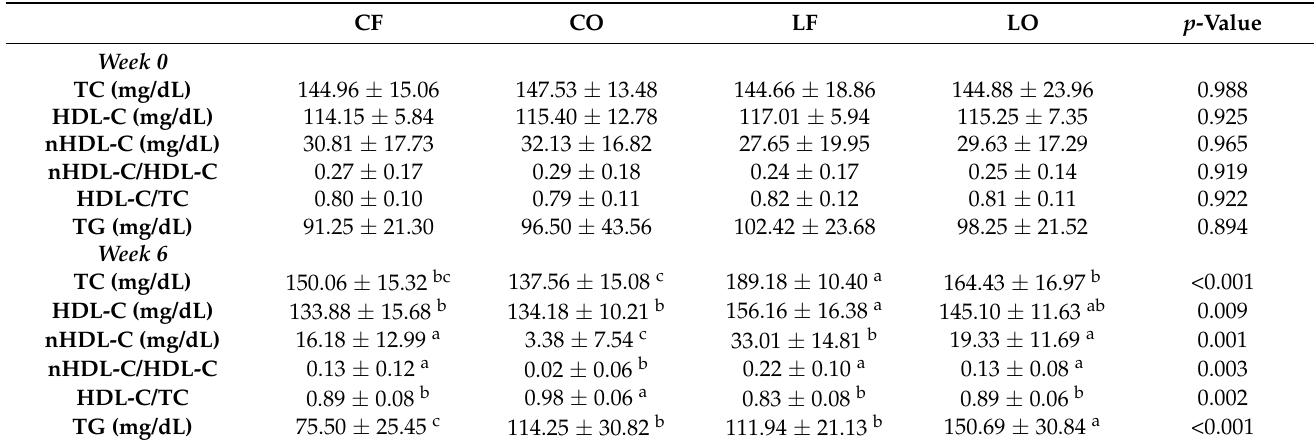
Table 4. Plasma lipid profile at Week 0 and Week 6 of hamsters fed one of the four diets: CF, fresh corn oil; CO, oxidized corn oil; LF, fresh lard; LO, oxidized lard *.